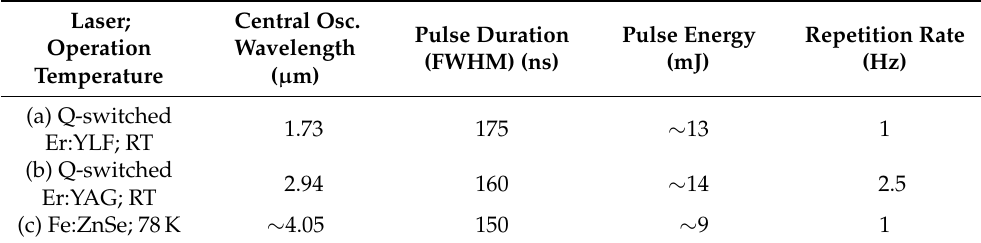
Table 1. Overview of three laser systems’ properties used for the excitation of crystal samples. RT—room temperature.